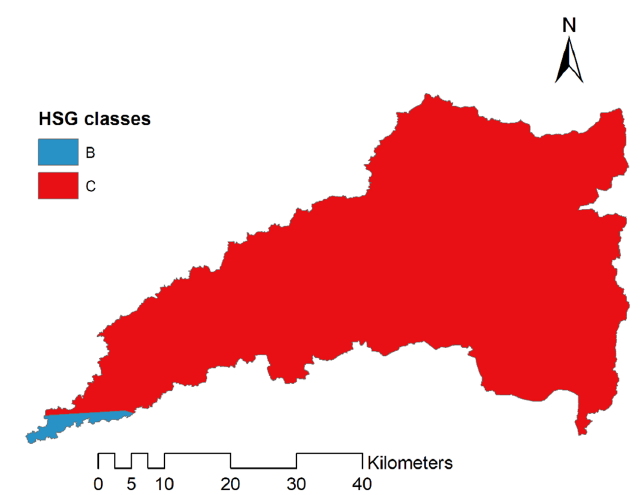
Figure 5. Hydrologic soil group (HSG) map of the study area.